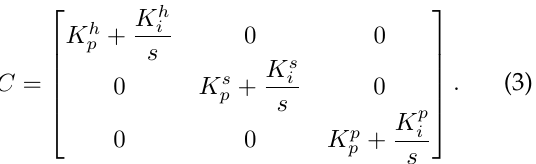
Fig. 3: Block diagram of the linear system model as- sumed for controller self-tuning. The inverse of the WEC intrinsic impedance Z i is used as the plant model.